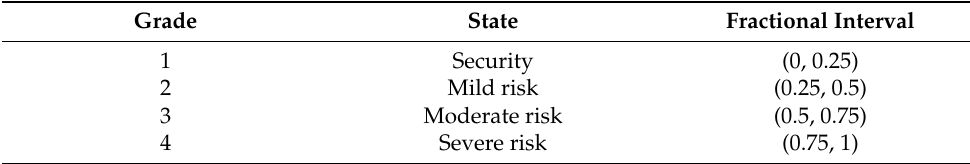
Table 10. Division of security